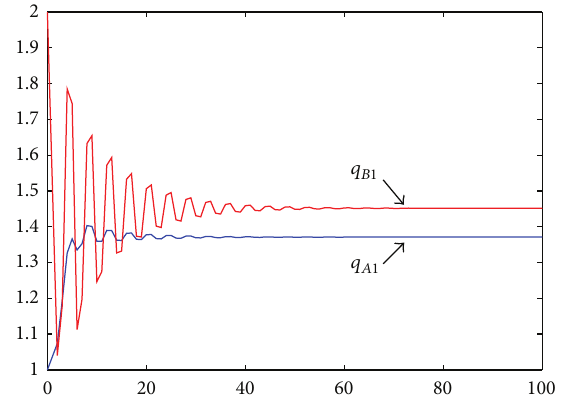
Figure 8: Evolution for the dynamic system (26) with the control- ling factor 𝑘 = 3.5